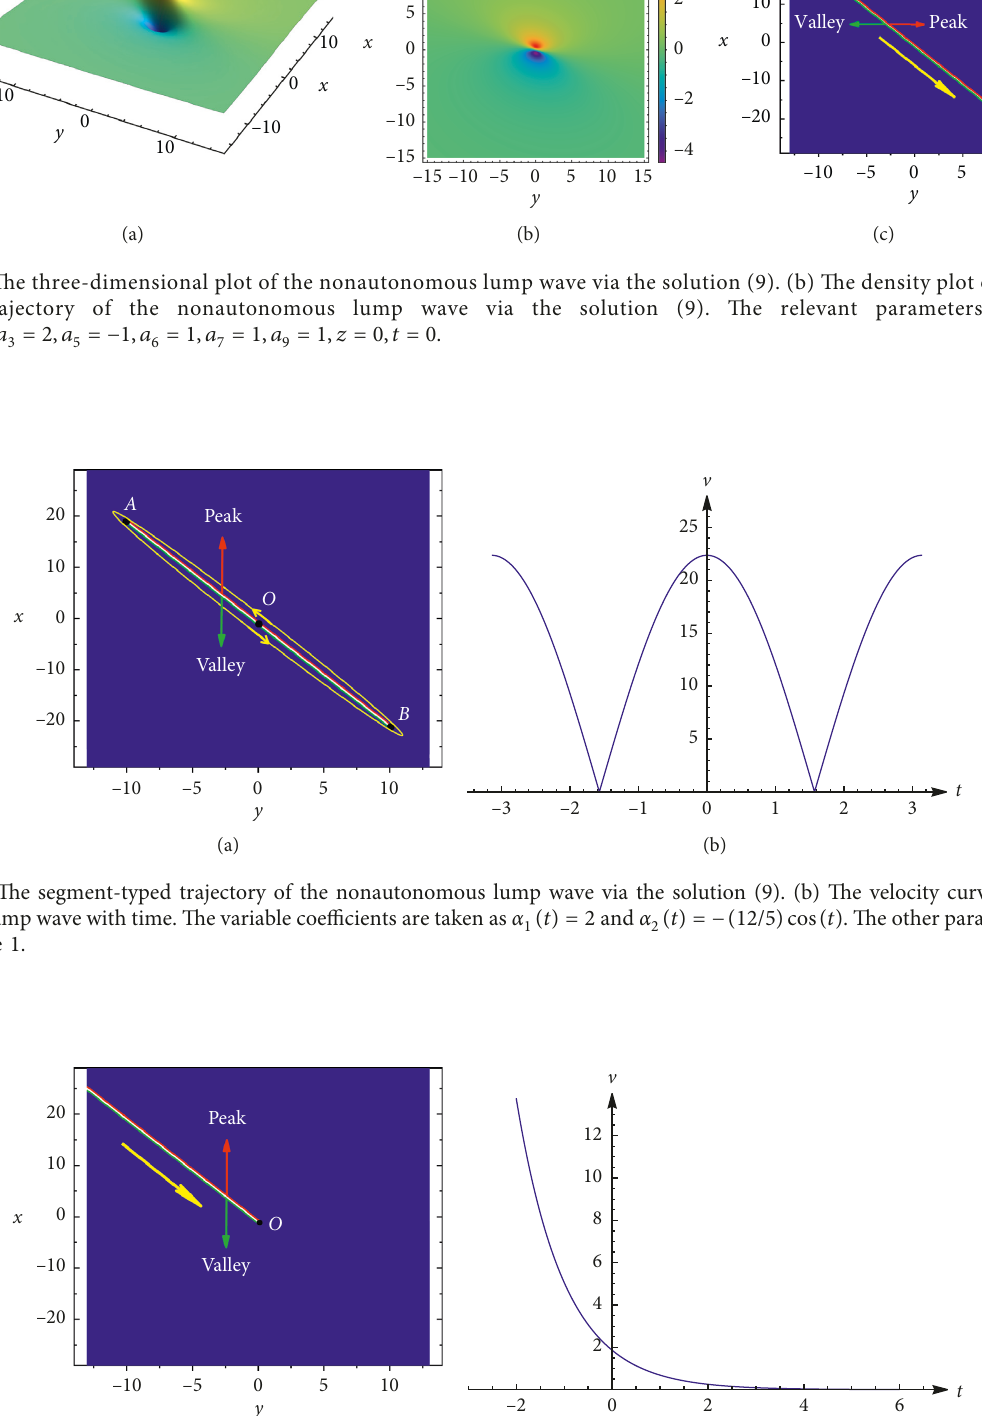
( t ) � 2 and α ( t ) � ( 1/5 ) e − t . The other parameters are the same 1 2